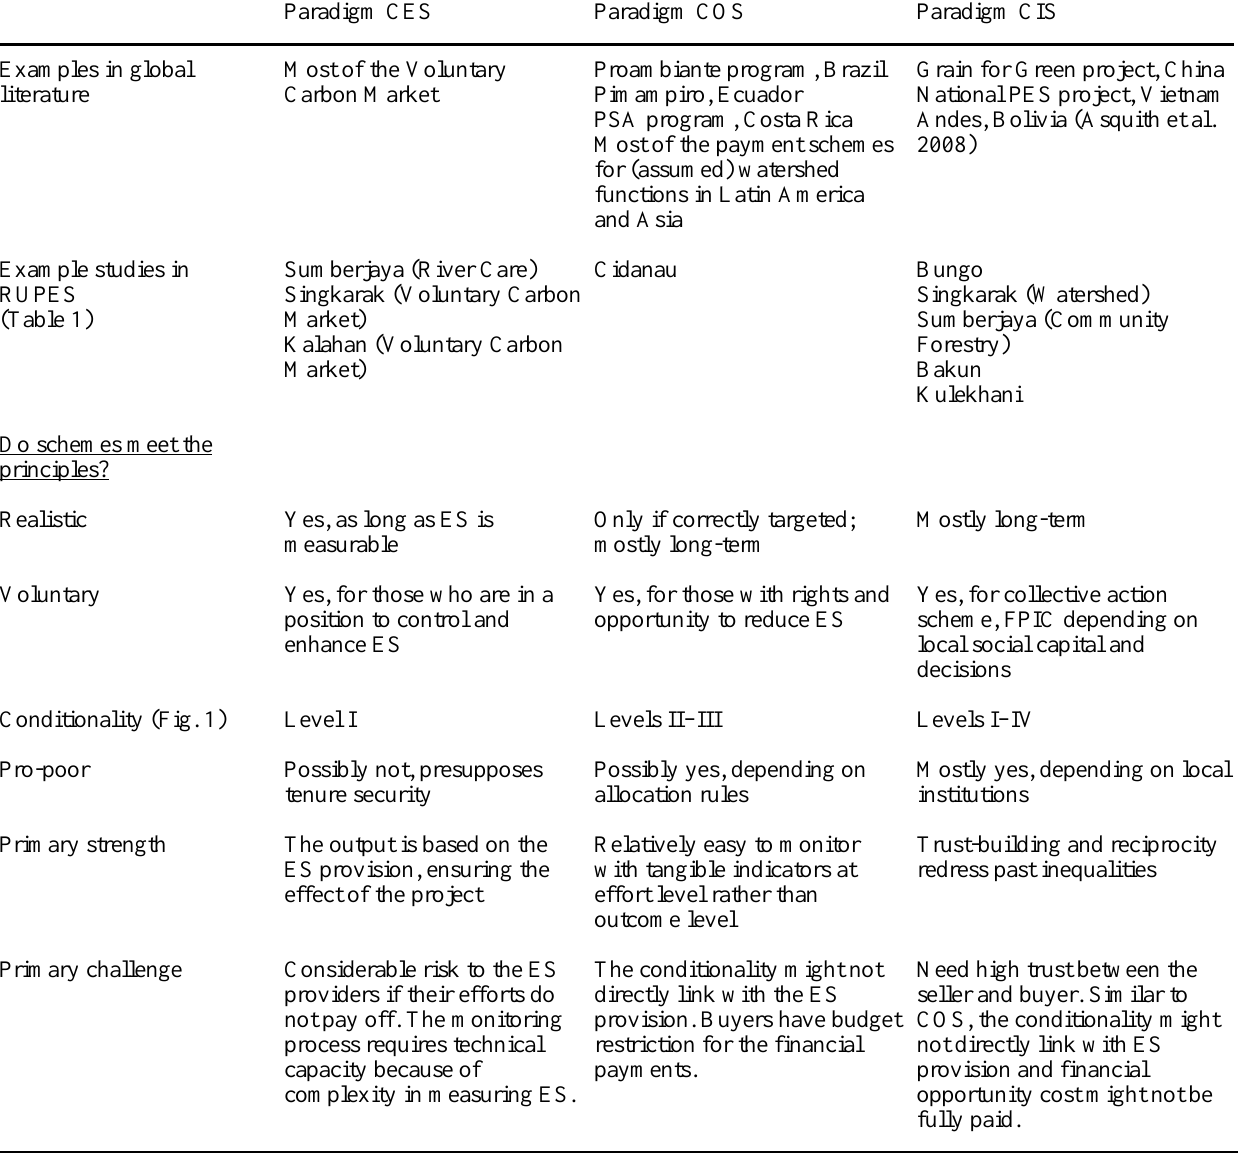
Table 2. Experience relevant to three contrasting paradigms across the RUPES sites (listed in Table